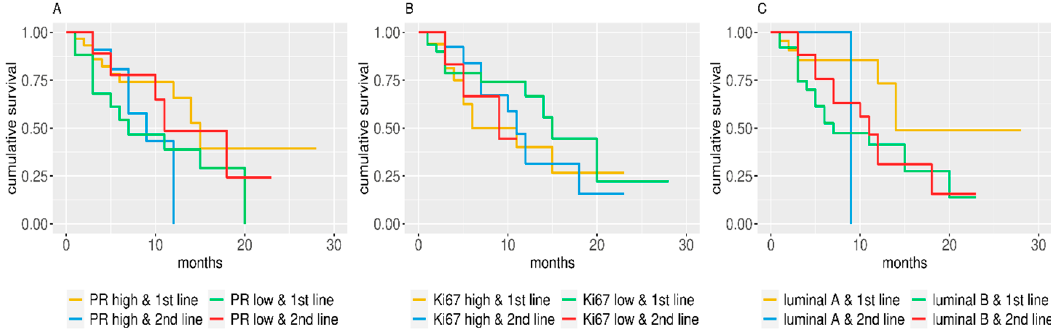
Figure 2. Kaplan–Meier estimated PFS curves for subgroups identified by line of treatment and ( A ) 139 PR dichotomic value, ( B ) Ki67 dichotomic value, and ( C ) and cancer subtype. 140